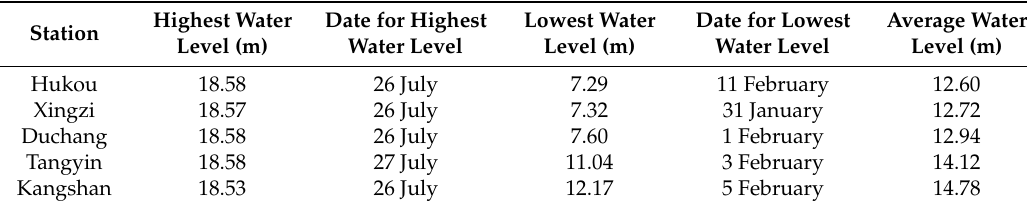
Table 1. Water level at five hydrological stations in